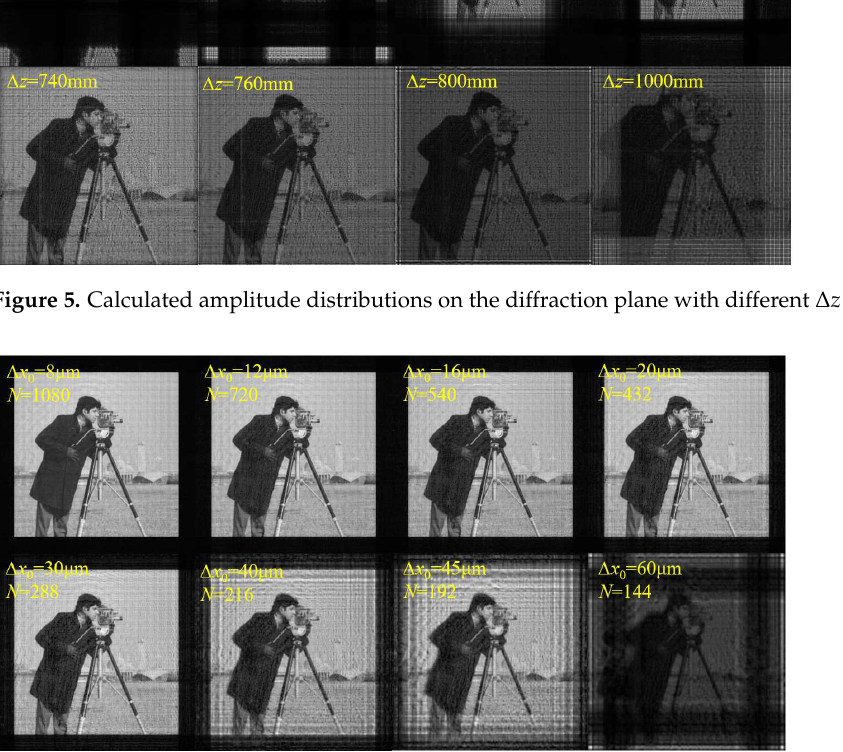
Figure 5. Calculated amplitude distributions on the diffraction plane with different ∆ z using SASM.